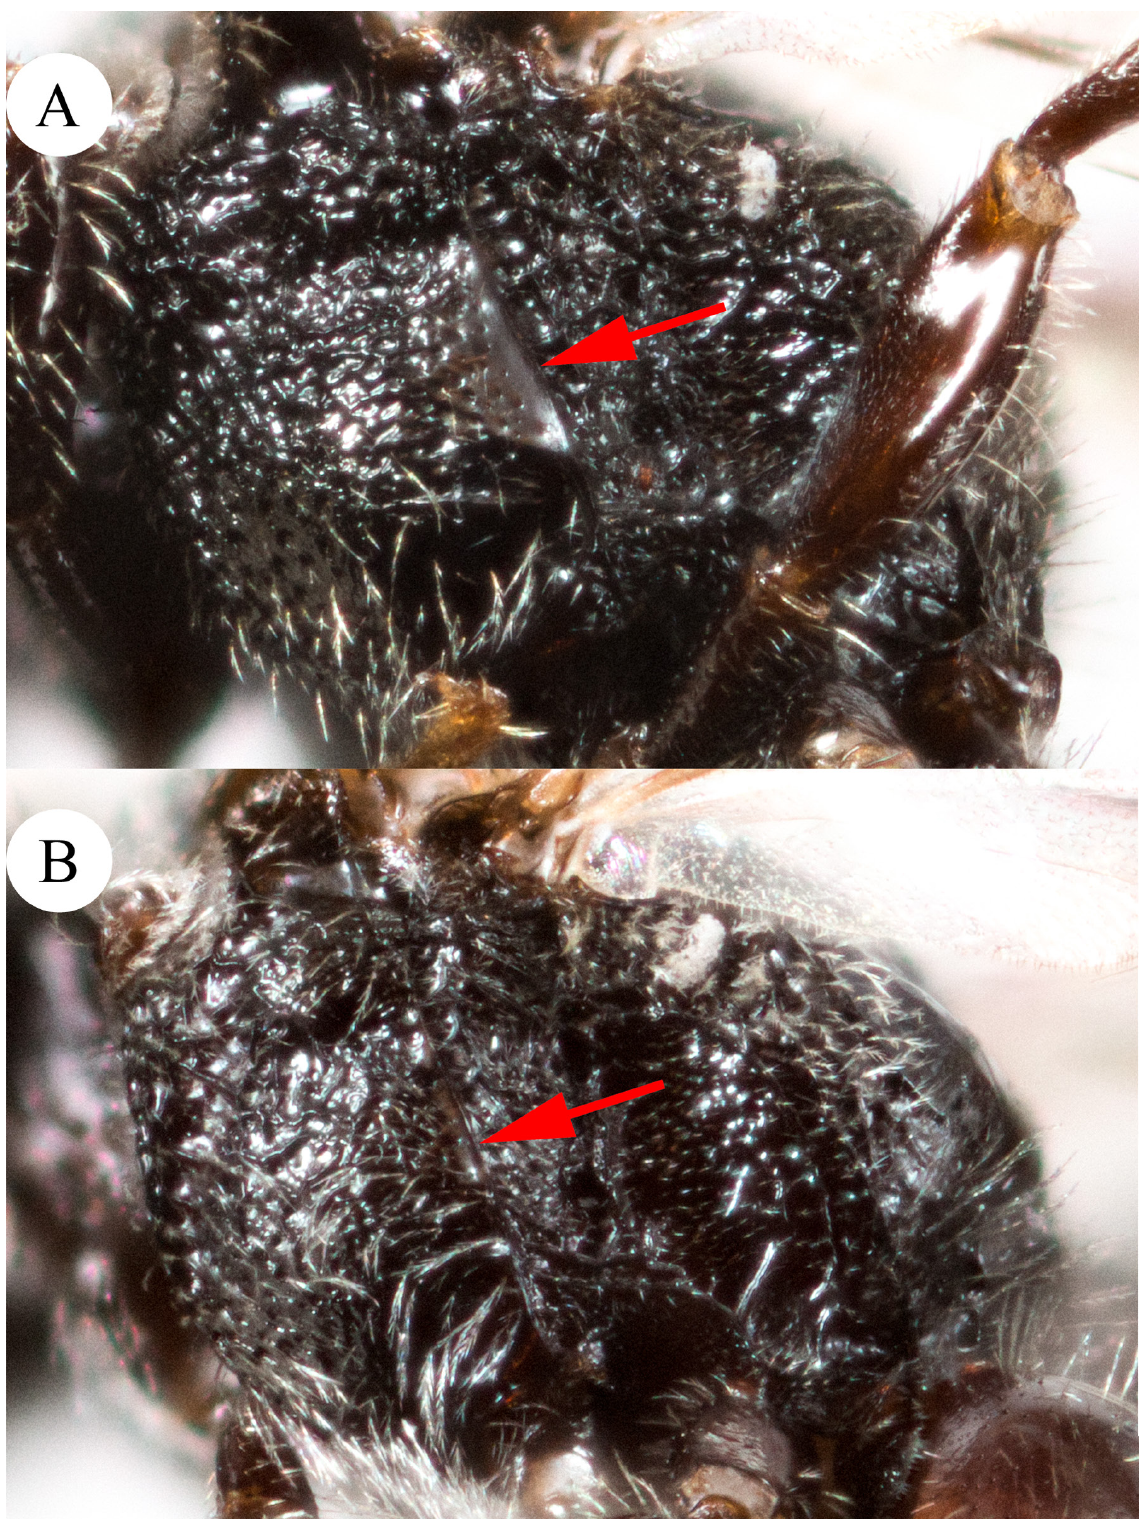
Fig. 13. Mesepisternum of species of Sphecodes Latreille, 1804 from Dominica. Arrows indicate smooth area on posterior margin. A . Sphecodes diablotinus sp. nov. B . S. albifacies sp.